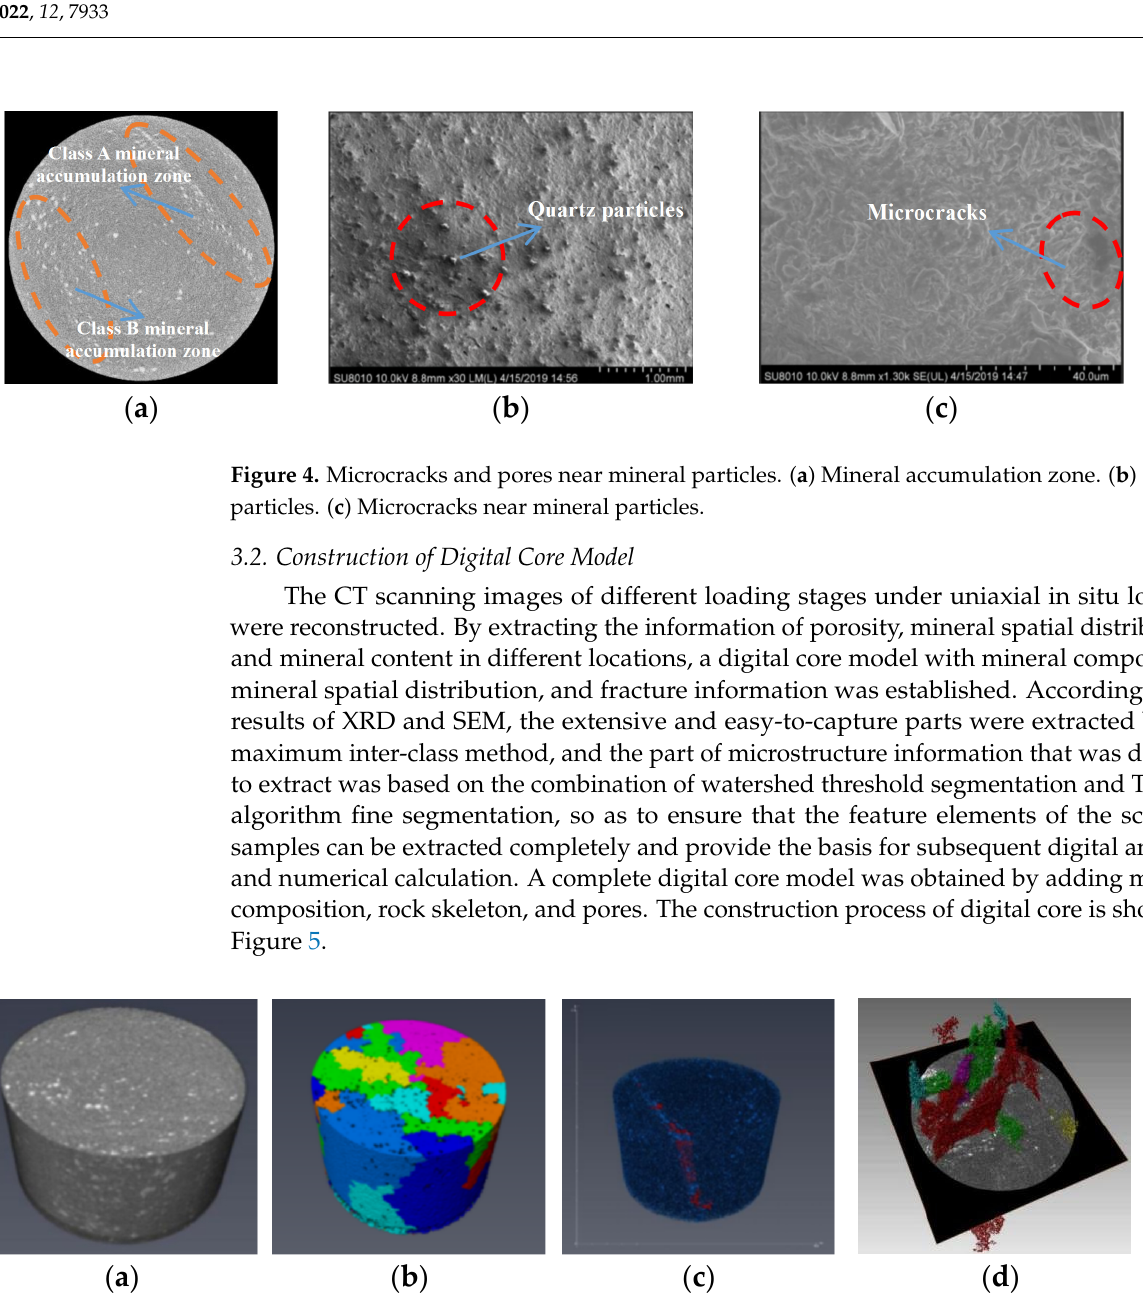
Figure 5. Gray image segmentation process. ( a ) Primitive mudstone. ( b ) Sub-block statistical feature. ( c ) Calculation of connectivity of mineral particles. ( d ) Extraction of aggregate mineral zone.